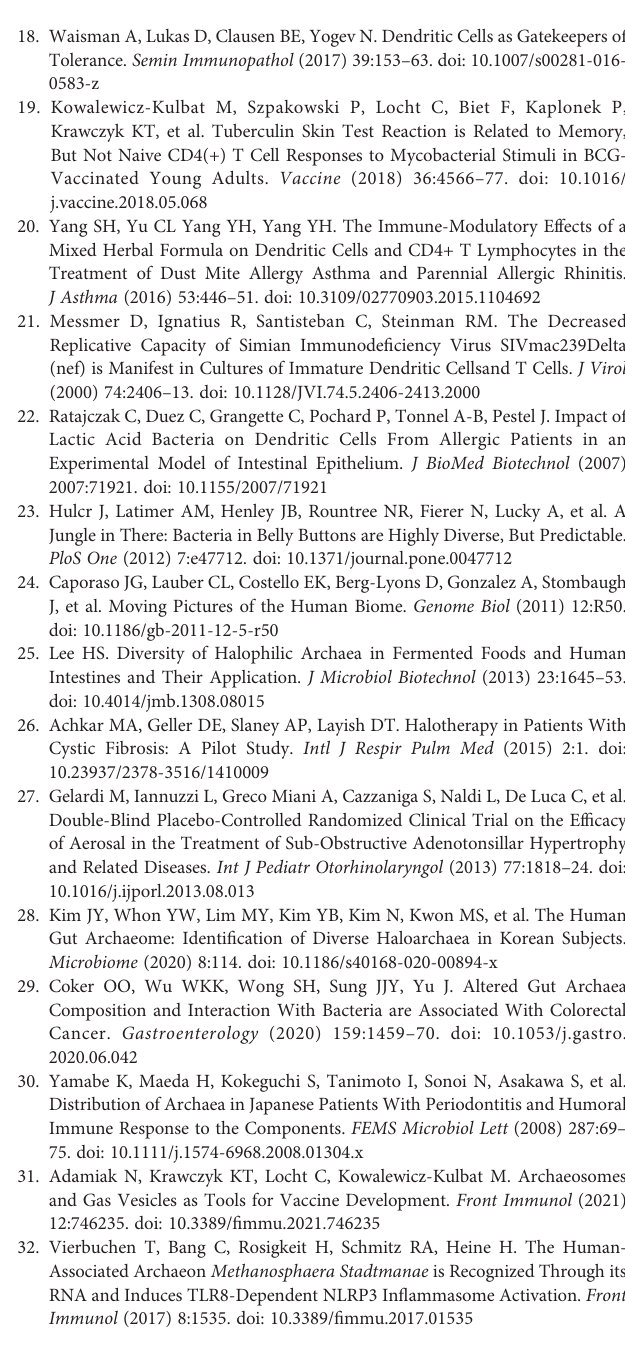
Supplementary Figure 6 | IL-17A secretion by CD4 + T cells co-cultured with halophile-stimulatedDCs.SecretionofIL-17AbyhumanCD4 + Tcellsfollowing96h co-culture with Hrd. rudnickae 64-, Hrd. rudnickae 66- or N. salaciae- pulsed autologous DCs (ratio DCs:T cells, 1:10) was measured in duplicates by ELISA. Data shown represent the means ± SD of 7 donors. Supplementary Figure 7 | Gating strategy for human DCs based on FSC/SSC criteria. Unstimulated DCs from blood donors were gated based on the forward (FSC) and side (SSC) scatter measurements (A) . Exemplary dot-plots showing human DCs stimulated for 24h with Hrd. rudnickae 64 and stained for CD86-FITC (B) or CD80-PE (C) are shown for one representative